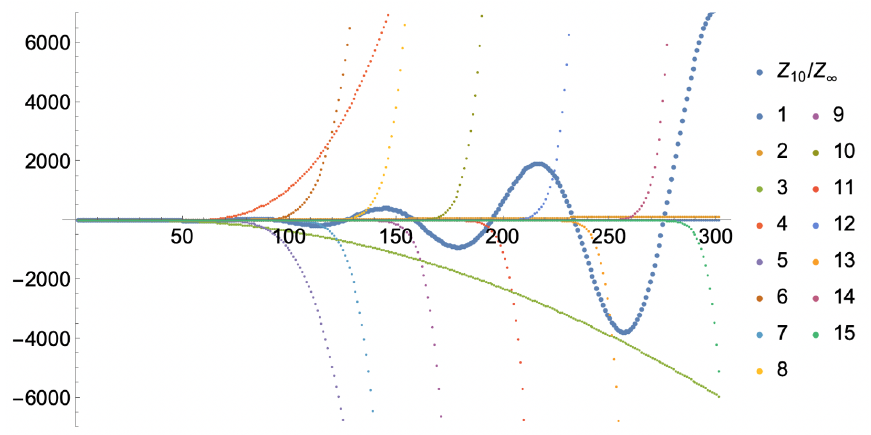
Figure 6 . Coefficients of the normalized half-BPS partition function Z N /Z ∞ with N = 10 (large blue) versus charge n . Large cancellations between brane partition functions x kN ˆ Z colors for increasing k up to k = 15 ) induce oscillations that are roughly of order N . The normalized spectrum can have negative coefficients but the unnormalized half-BPS spectrum is always